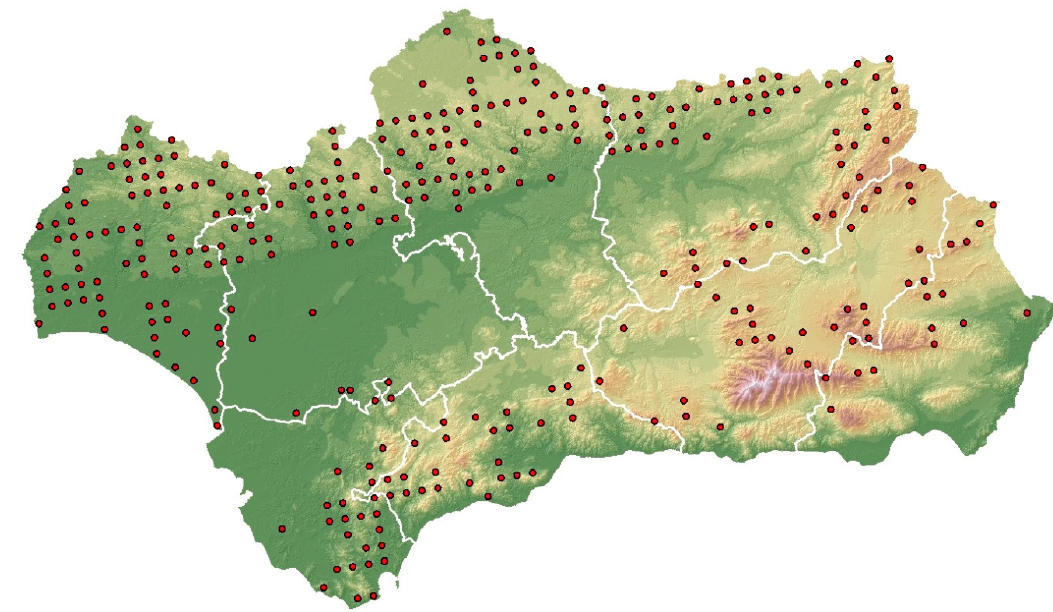
Figure A1. Point location of the Andalusia Forest Health Network (SEDA network) distribution within Andalusia.